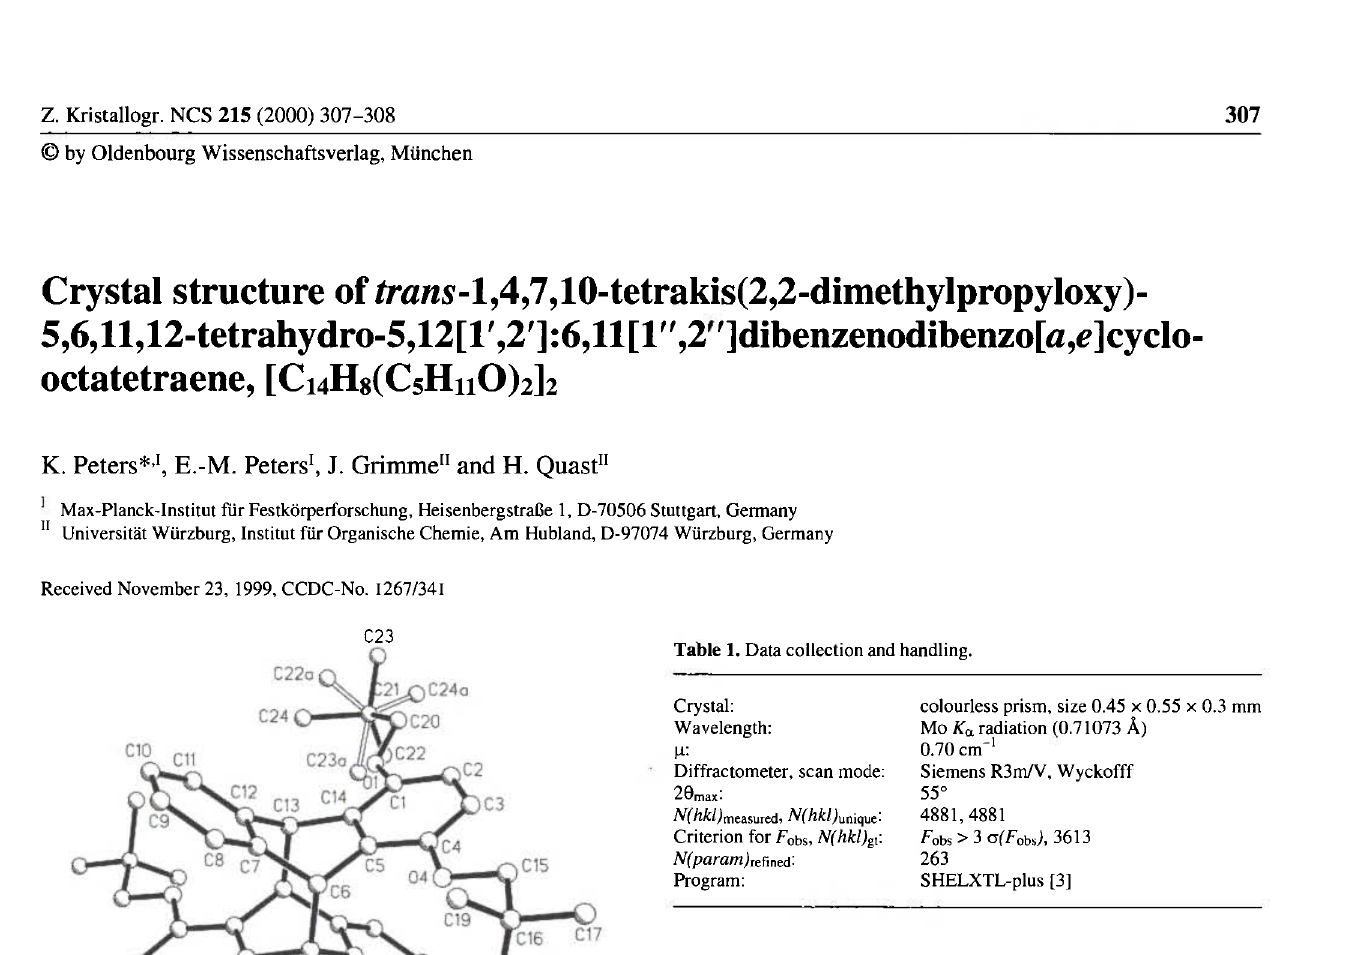
Table 2. Atomic coordinates and displacement parameters (in A